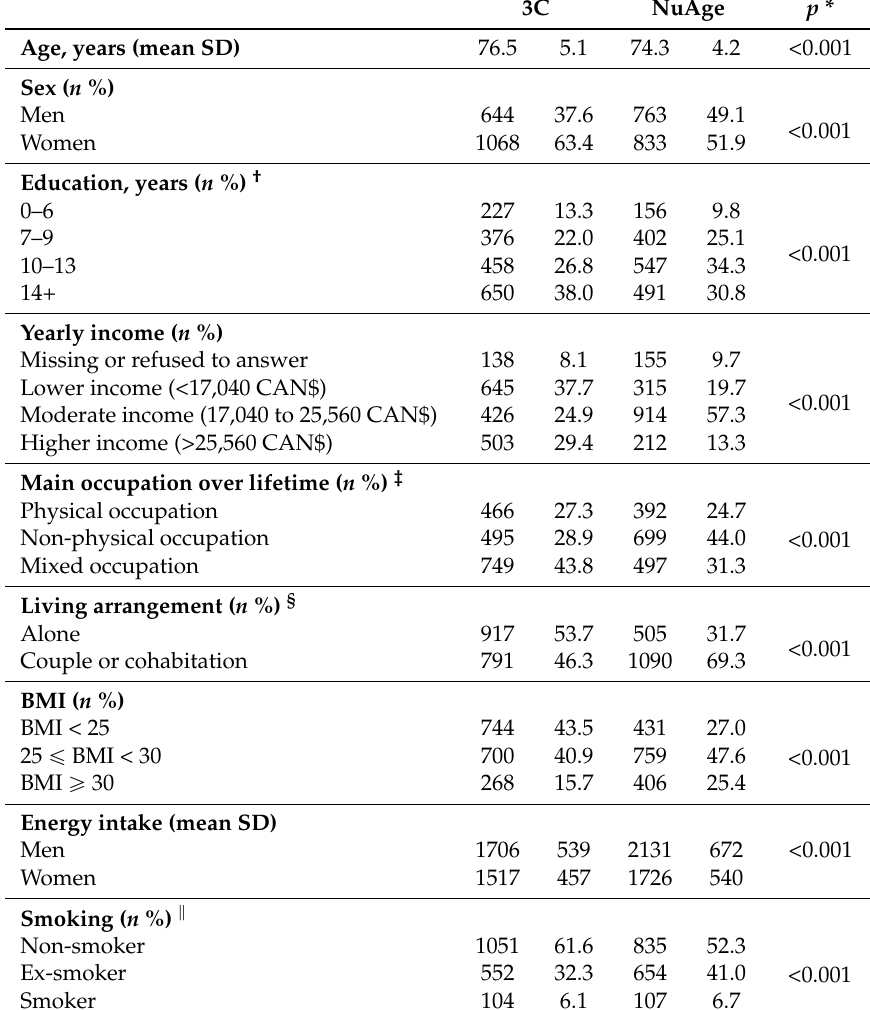
Table 1. Characteristics of the 3C study sample ( n = 1712) and the NuAge study sample ( n =